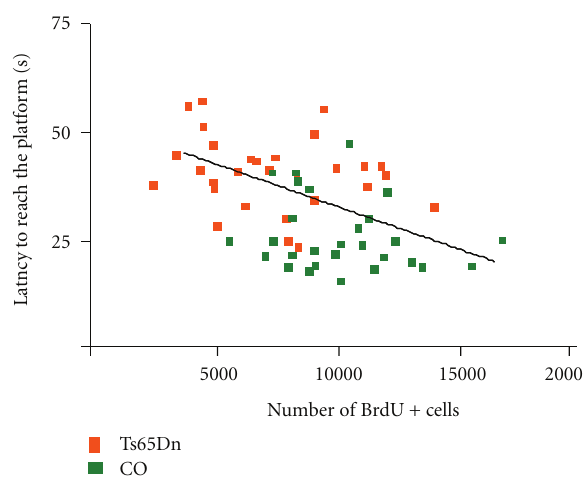
Figure 2: Correlation between performance in the Morris water maze (mean latency to reach the platform) and the number of BrdU+ cells in the DG of Ts65Dn and euploid littermates (Rueda et al., unpublished results; Pearson’s R : − 0.4647; P < 0 .